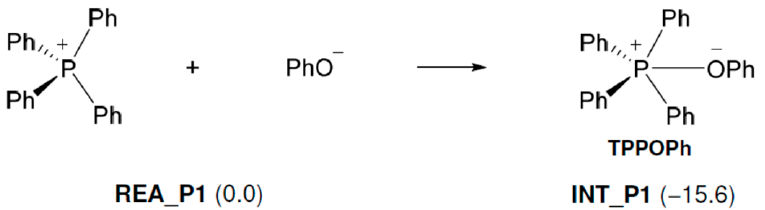
Figure 2. Free energy changes in the tetraphenylphosphonium phenolate-forming reaction. Relative free energies (kcal/mol) to REA_P1 are in parentheses.